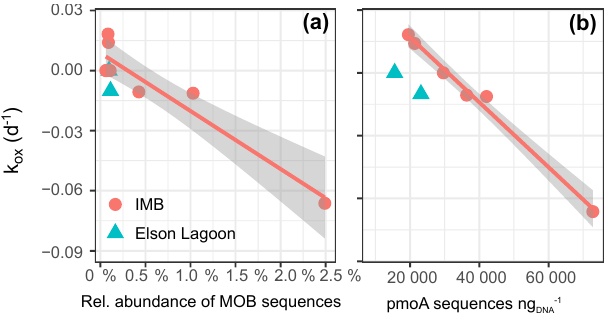
Figure 7. Correlation between net oxidation rate constant ( k ox ) and the relative abundance of sequences in 16S-MOB-OTUs, = 0.84 (a) and number of pmoA sequences with R 2 ( MOB − OTUs ∼ kox ) = 0.85 (b) . For correlation to the number of total R 2 ( pmoA ∼ kox ) methylotroph OTUs (which includes MOB and non-MOB methy- = 0.81. The gray shaded lotrophs in total 16S) R 2 ( Meth − OTUs ∼ kox ) area shows the 95% confidence interval of the